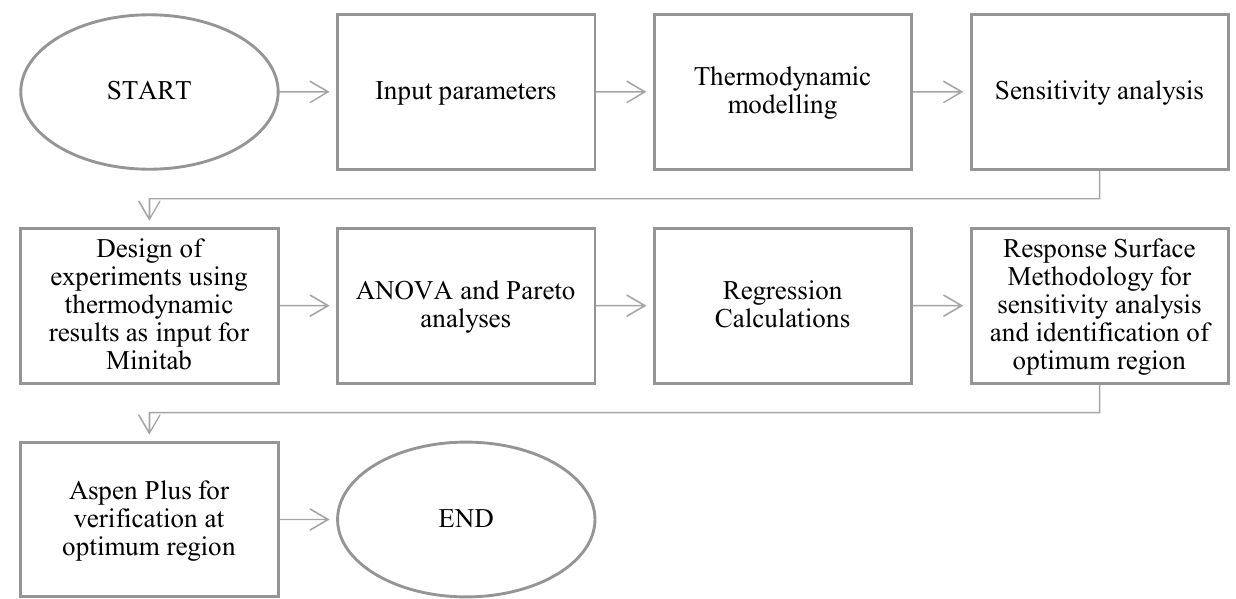
Figure 2. Flowchart for modelling and optimization of biomass steam gasification process. Adapted from [50].